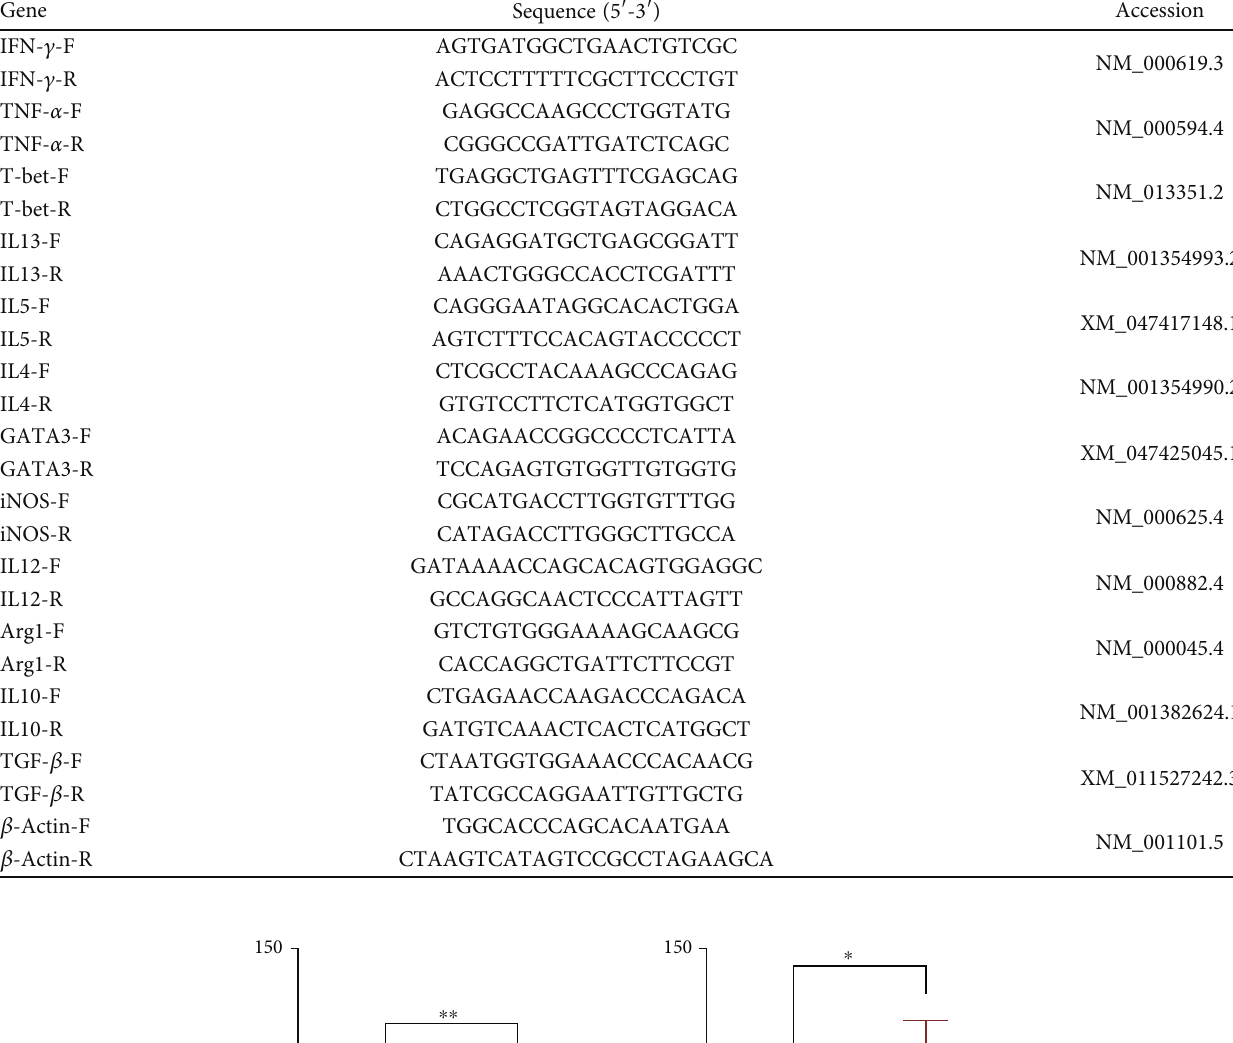
Table 2: The primer sequences for RT-PCR.